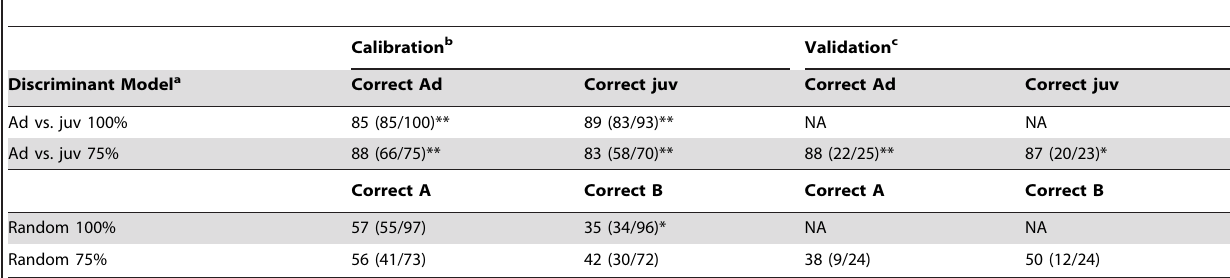
Table 5. Application of near infrared spectroscopy of feces to discriminate between adult and juvenile captive giant pandas ( Ailuropoda melanoleuca ) housed in US